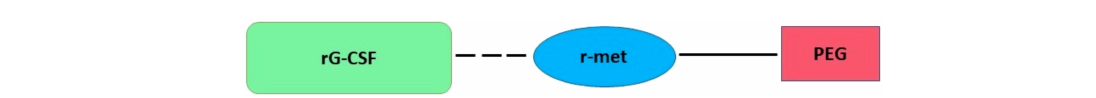
FIGURE 1 Plan structures of peg fi lgrastim. Covalently bound of a single 20-kDa PEG molecule attached to the recombinant N-terminal methionine (r-met) residue of